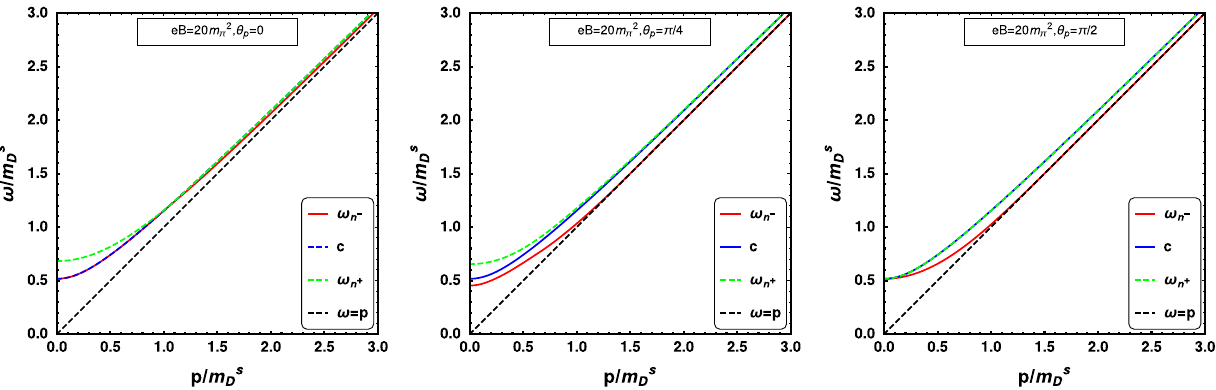
Fig. 3 The plot of dispersion of the three modes ( n − , c and n + modes) of a gauge boson in strong field approximation for propagation angles θ = 0 , π/ 4 and π/ 2 at eB = 20 m 2 = 0 . 2 GeV. ω = p represents the light π and T p